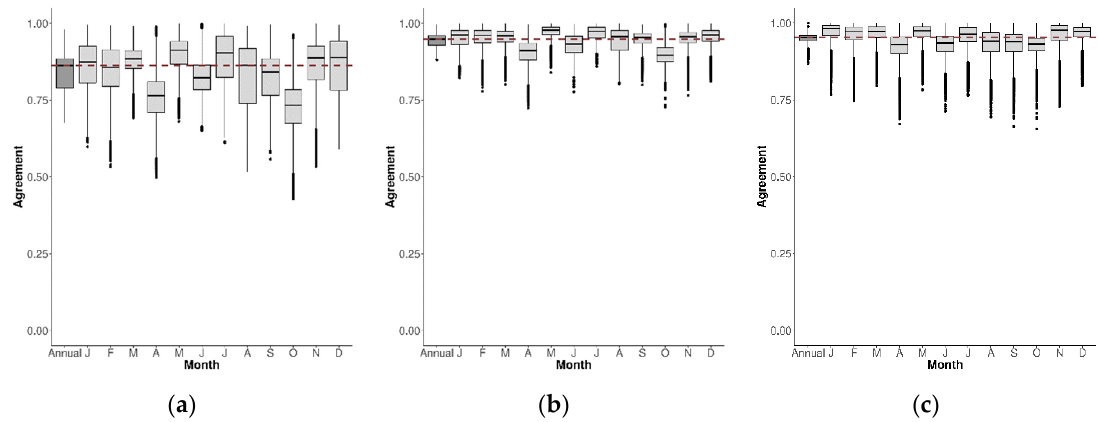
Figure 4. Distribution of agreement ( A ) between the WRF-Chem simulations, with and without aerosol feedback, for the analysed meteorological variables: ( a ) solar radiation; ( b ) air temperature; and ( c ) precipitation. The first box represents annual agreement values and the remaining represent monthly ones. Each box includes the agreement obtained for the 36,000 grid cells, and it is delimited by the 25th and 75th percentiles and the middle line representing the 50th percentile of the distribution of the agreement. The threshold for outliers’ identification (black dots) is based on 1.5 times the interquartile range. Red dashed line shows the median of the annual agreement.